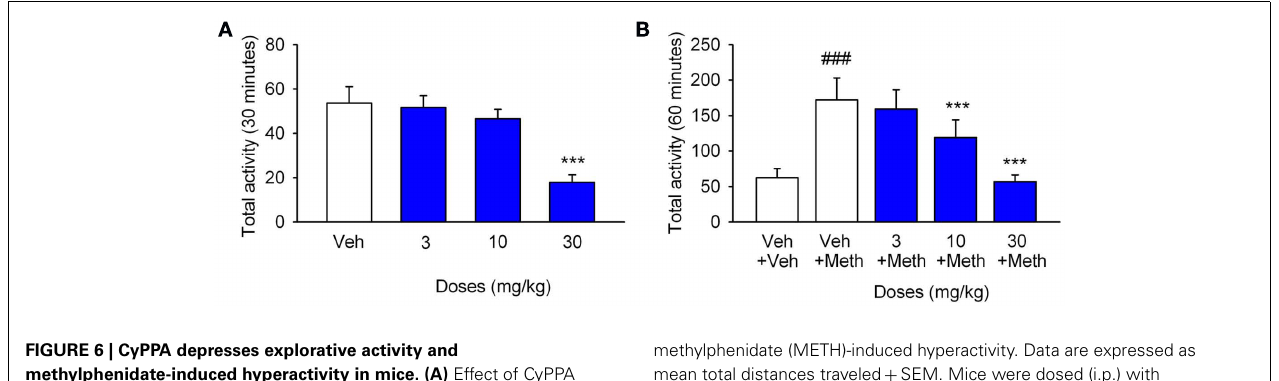
FIGURE 6 | CyPPA depresses explorative activity and methylphenidate-induced hyperactivity in mice. (A) Effect of CyPPA on basic explorative activity. Data are expressed as mean total distances traveled + SEM. Mice were injected with vehicle (i.p.; open bar) or CyPPA (3, 10, and 30mg/kg, blue bars) 15min before testing. *** P < 0.001 versus vehicle treated group (two-way ANOVA followed byTukey’s multiple comparison test, n = 7). (B) Effects of CyPPA on